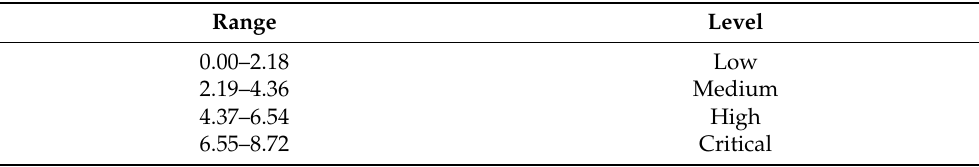
Table 11. New risk scores with levels.